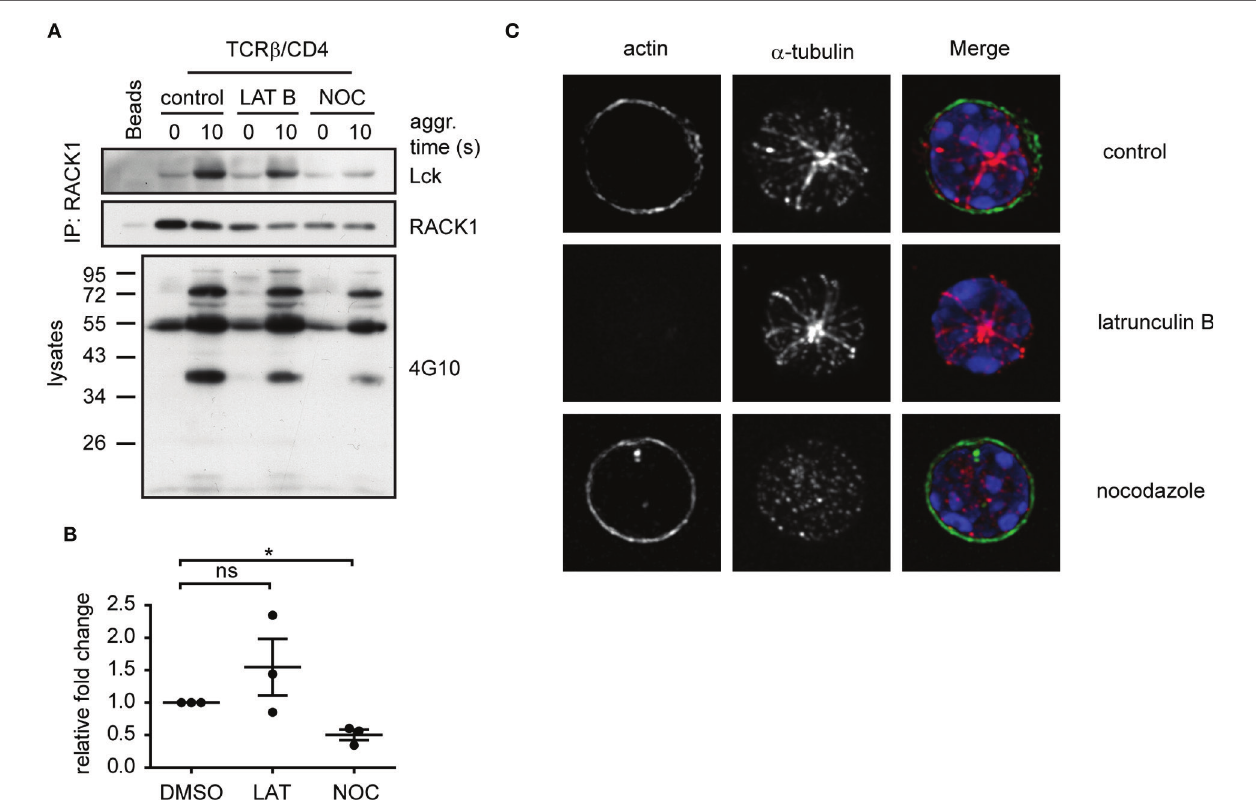
FigUre 7 | Functional microtubular network is important for racK1–lck complex formation upon T-cell activation . (a) CD4 + T-cells were pretreated with latrunculin B (LAT B), nocodazole (NOC), or DMSO (control) and then activated for the indicated period of time followed by lysis in TNE lysis buffer. RACK1 was immunoprecipitated and blotted against Lck and RACK1. Samples from lysates before IP were boiled and subjected to pY western blot analysis with 4G10 antibody. Blots are representative of three independent experiments. (B) Statistical analysis of (a) , Lck panel, represents the relative fold-change of RACK1 co-immunoprecipitated Lck normalized to total RACK1. The untreated control samples were given reference value “1.” The statistical analysis presented as mean ± SD was performed using the Student’s two-tailed t -test, * p < 0.05, n.s., not significant. (c) CD4 + T-cells treated with DMSO (control); nocodazole or latrunculin B were pre-warmed at 37°C and fixed by PFA on polylysine coverslips. Tubulin (red) and actin (green) were visualized by confocal microscopy. Nuclei were stained with DAPI (blue). Representative images show the maximal intensity projection (MIP) of z